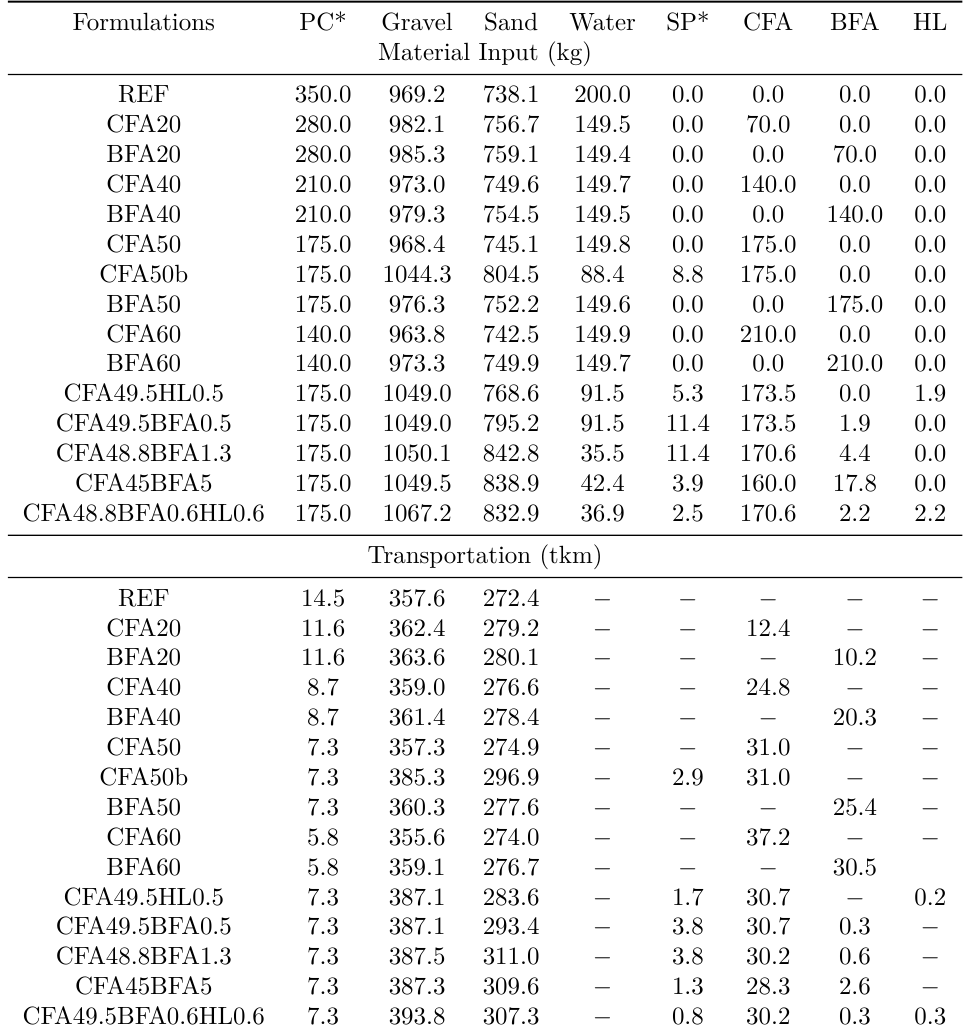
Table 2. Binder Inventory results of the material and transportation inputs for each concrete (per m 3 of produced concrete)